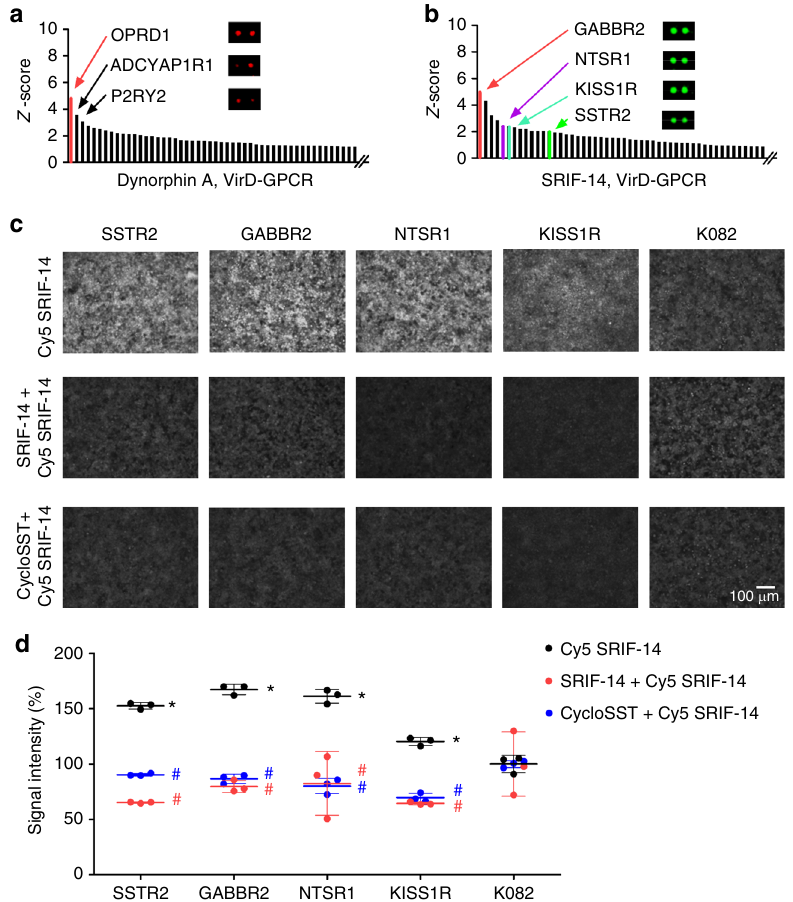
Fig. 3 Identi fi cation and cell-based validation of peptide ligand – GPCR interactions. a Commercially available Dynorphin A was Cy5-labeled and probed to a VirD-GPCR array. Quantitative analysis showed that it bound to VirD-OPRD1 with the highest Z -score followed by ADCYAP1R1 and P2RY2. b A commercially available peptide SRIF-14 was Cy3-labeled and probed to a VirD-GPCR array. Quantitative analysis revealed that it bound to several unexpected off-targets in addition to its canonical receptor, SSTR2. c Vero cells were separately infected with SSTR2, GABBR2, NTSR1, KISS1R, or K082 virus. Infected cells were then incubated with Cy5-labeled SRIF-14 at 8 µ M in the absence (upper panel) or presence of cold SRIF-14 (middle panel) or cyclosomatostatin (cycloSST, lower panel). d Quantitative analysis of binding signals. Each binding assay was performed in triplicate and the obtained binding signals were normalized to those of the K082 controls. Data were analyzed by two-way ANOVA with repeated measures followed by Bonferroni post-test. * P < 0.05, comparison between VirD-GPCRs and K082 in the absence of competitor ligands; # P < 0.001, comparison between binding signals obtained in the absence and presence of the competitor ligands. n = 3, biologically independent